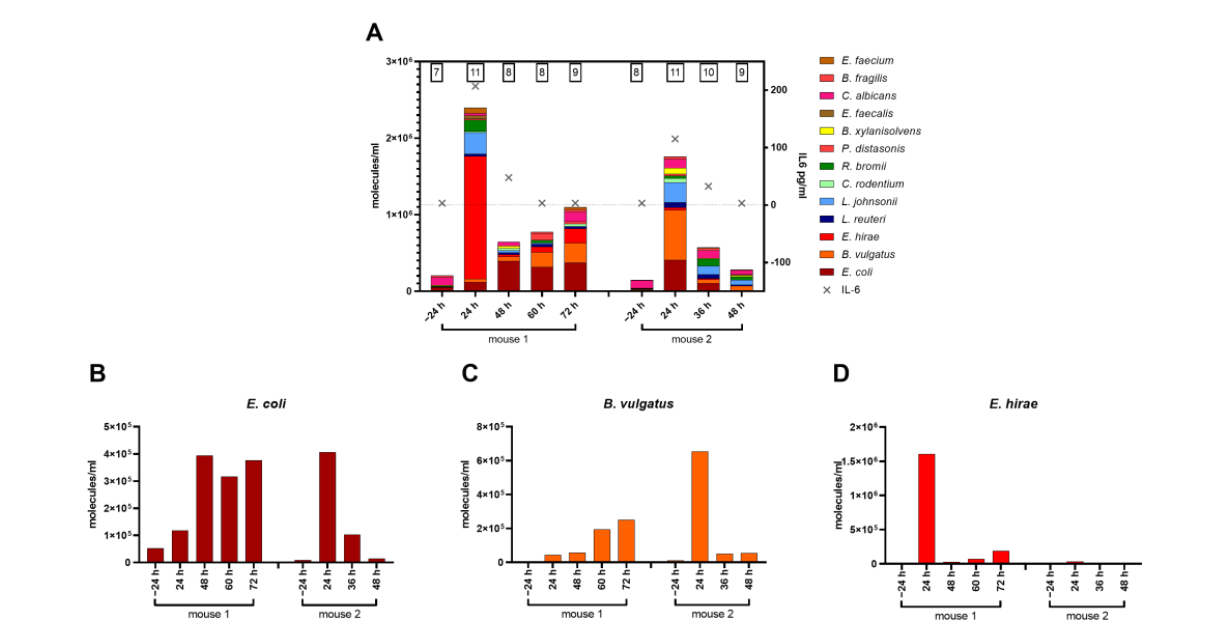
Figure 7. ( A ): Concentration for top species shown in molecules/mL of serial blood samples for two mice at different time points. The numbers above bars indicate the number of detected top species. Crosses indicate a corresponding IL-6 concentration in the blood per time point. ( B – D ): Time course of the most abundant species in molecules/mL of serial blood samples in two individuals.